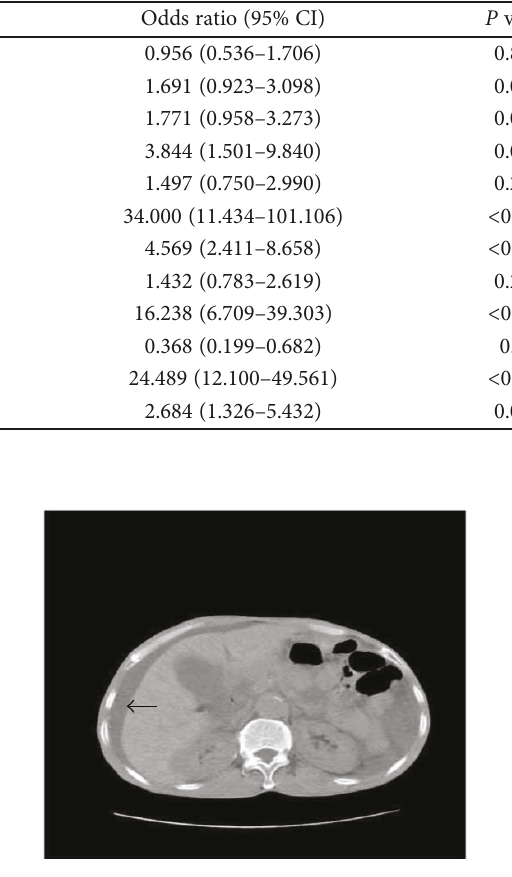
Figure 1: Computed tomography scan of the abdomen showing a large quantity of ascites (black arrow) around the